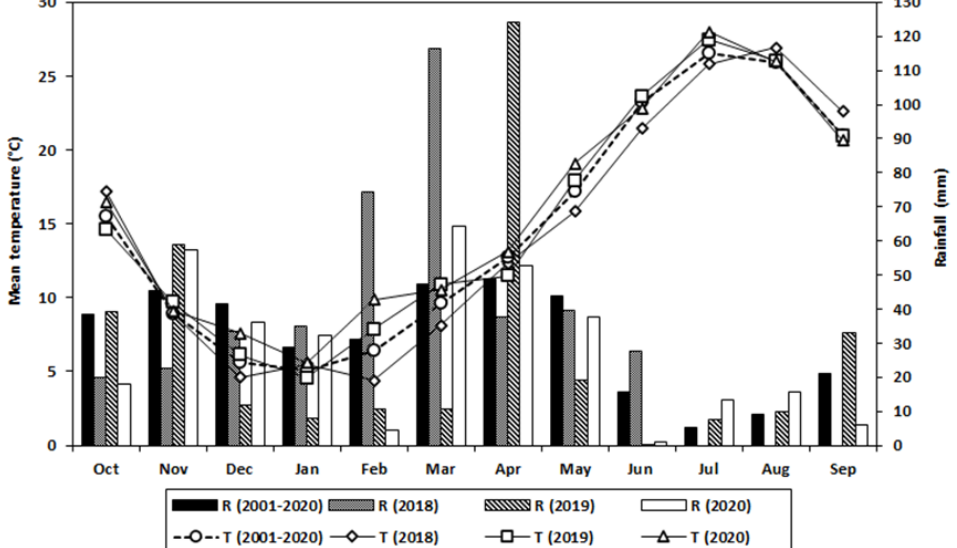
Figure 1. Total rainfall (bars) and monthly mean temperature (points and lines) at the experimental site during the 2018, 2019, and 2020 agronomic years and the 20-year averages (2001–2020). The soil at the study site is classified as Petric Calcisol (FAO soil classification) or Petrocalcic Calcixerept (USDA soil classification), typical of the La Mancha region. The main characteristic of this soil is the presence of a dense C km horizon 30 cm below the surface, impenetrable to grapevine roots. Subscripts k and m indicate carbonate accumulation and strong cementation or hardening, respectively. The pedoclimatic soil conditions are characterized by the typical xeric moisture regime of Mediterranean climates. The vineyard soil was managed mechanically by mowing the permanent natural plant cover throughout the year. Water was supplied to the vineyard by rainfall. However, at specific times, it was